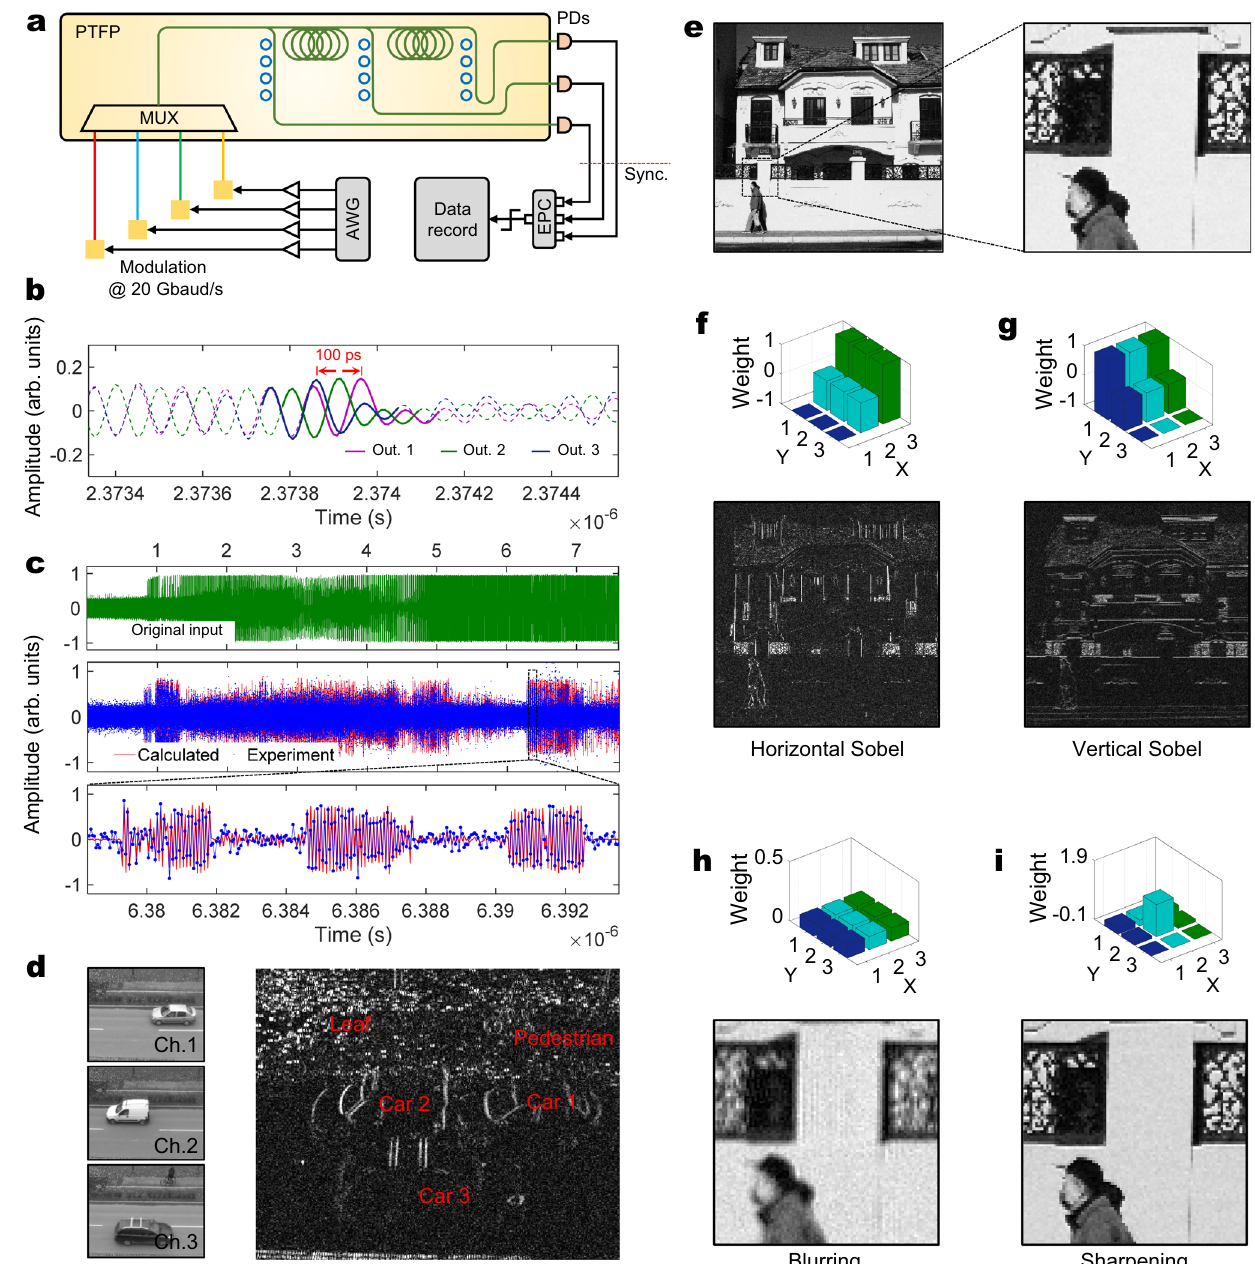
Fig. 3 | Experimental results of tensor convolution. a Conceptual experimental setup of the PTFP chip. MUX, wavelength multiplexer; AWG, arbitrary waveform generator. The generated signals are ampli fi ed and modulated on the optical car- rier. Afterthe tensor convolution,digitaldata isrecorded atthe output of the EPC. b Output synchronization. In synchronization, only one waveform is used to input one signal. The waveforms of different output ports are identical with different delays. We highlight an identical segment of these waveforms with thicker line- width. c Output samples of the 1×3 convolutions. The original input is given for